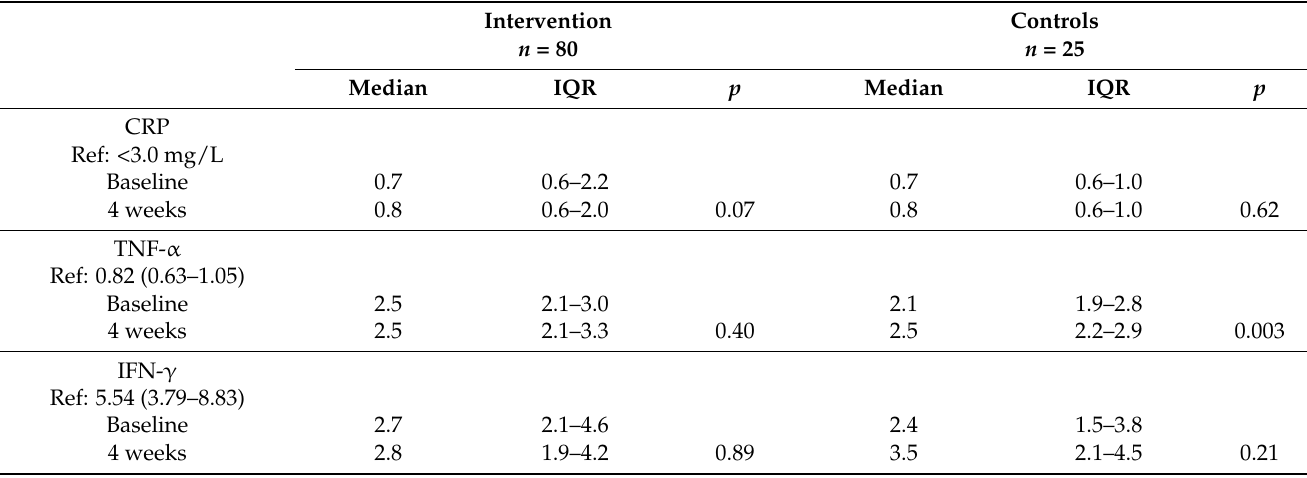
Table 4. Plasma CRP and cytokine concentrations before and after the SSRD intervention. Intervention n =